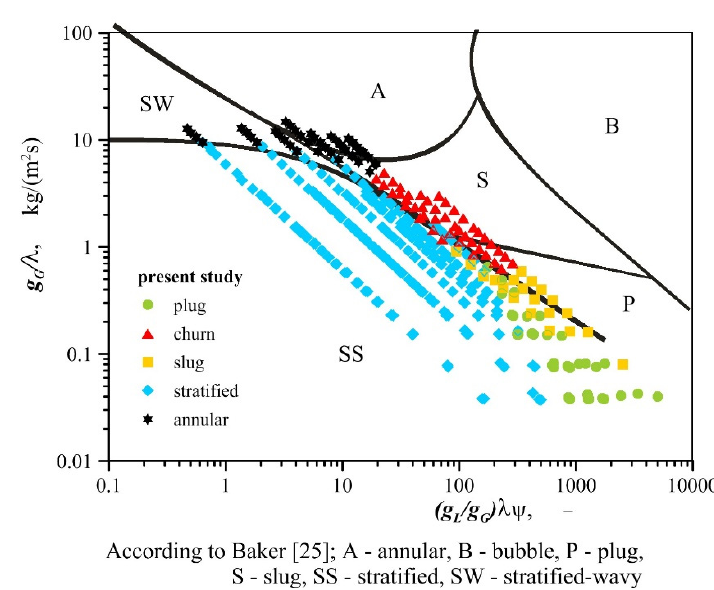
Figure 7. Ranges of pattern formation during gas − liquid flow through channels with metal foam packings vs. map developed by Baker [25].